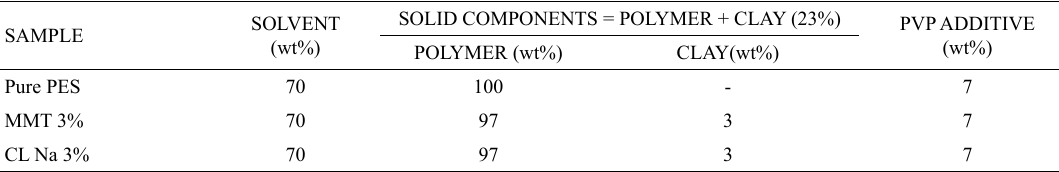
Table 1. Compositions of the spinning solutions.